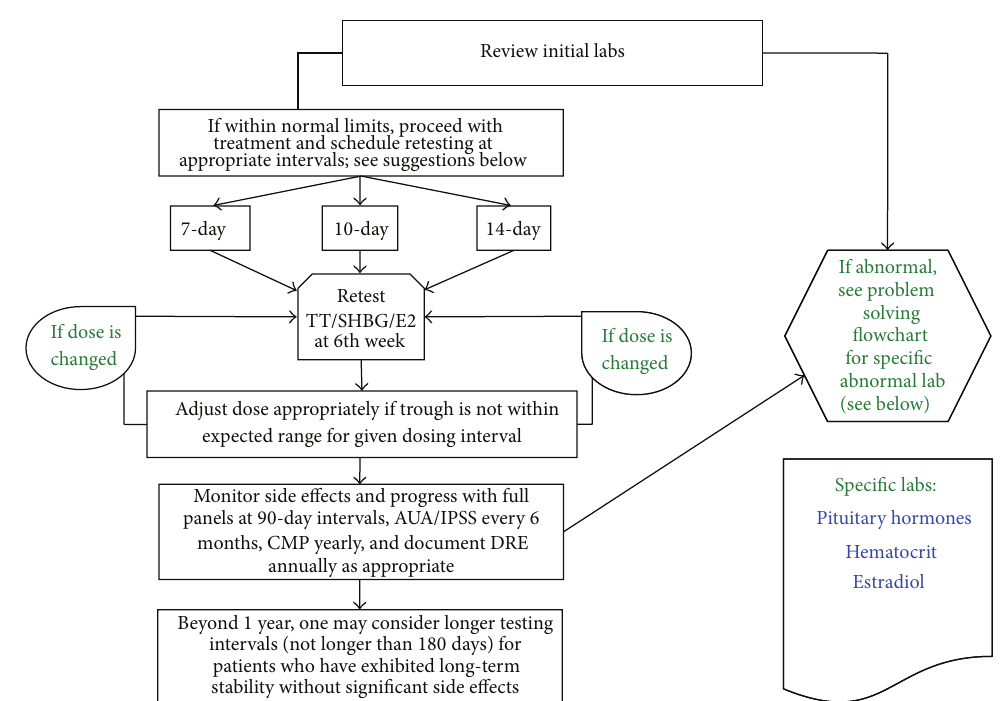
Figure 2: Flow diagram for follow up patients at a Low T